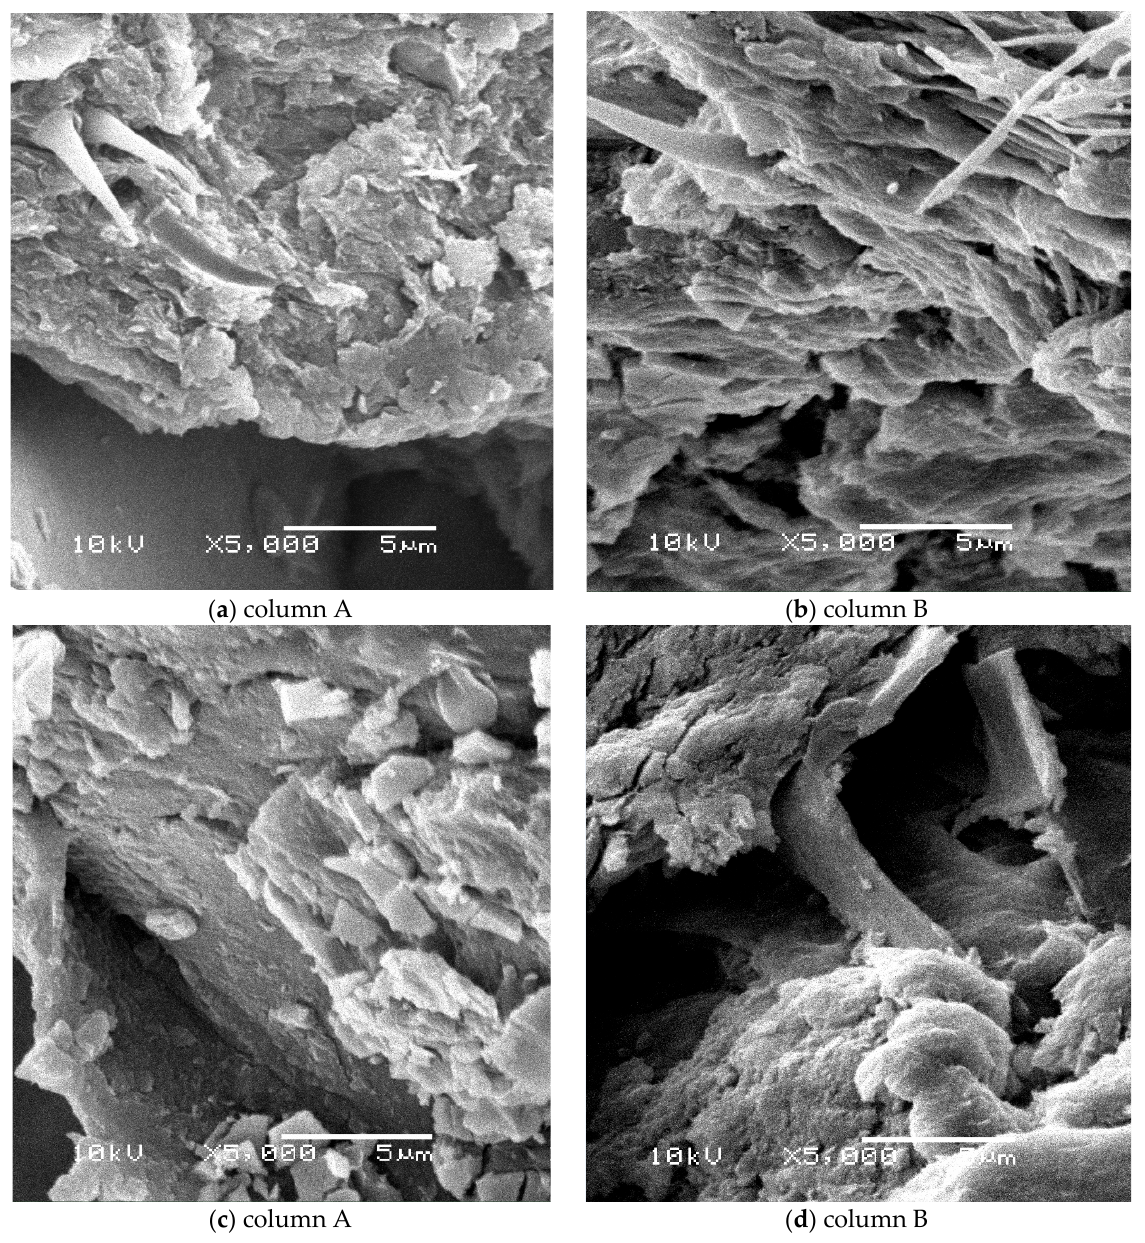
Figure 4. Microorganisms observed in the structure of waste polyurethane foams ( a , b ) bluish-green; ( c , d ) yellow-green (single colonies of bacteria are marked with arrows).